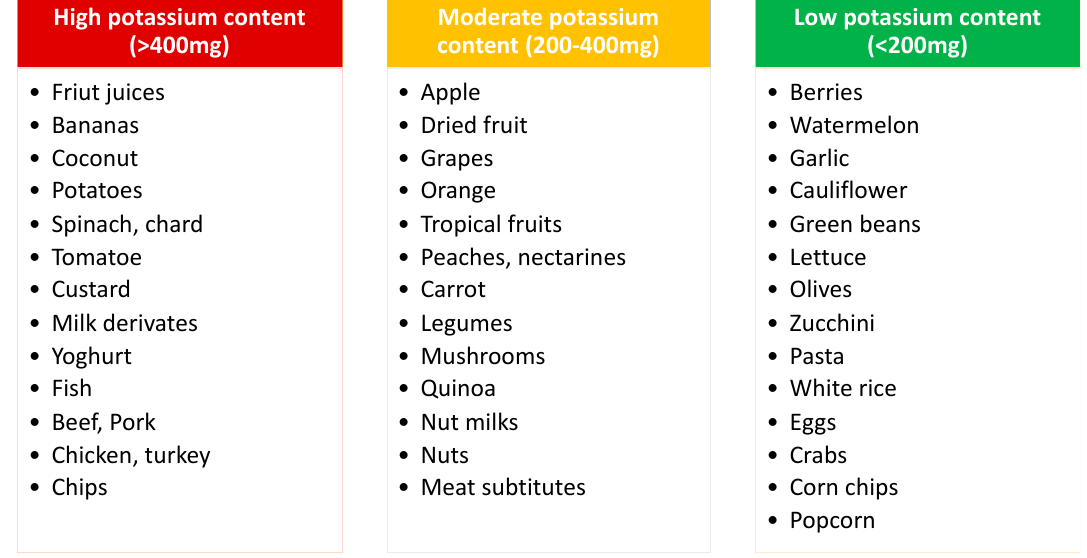
Figure 1. Dietary potassium content. Adapted from [21].